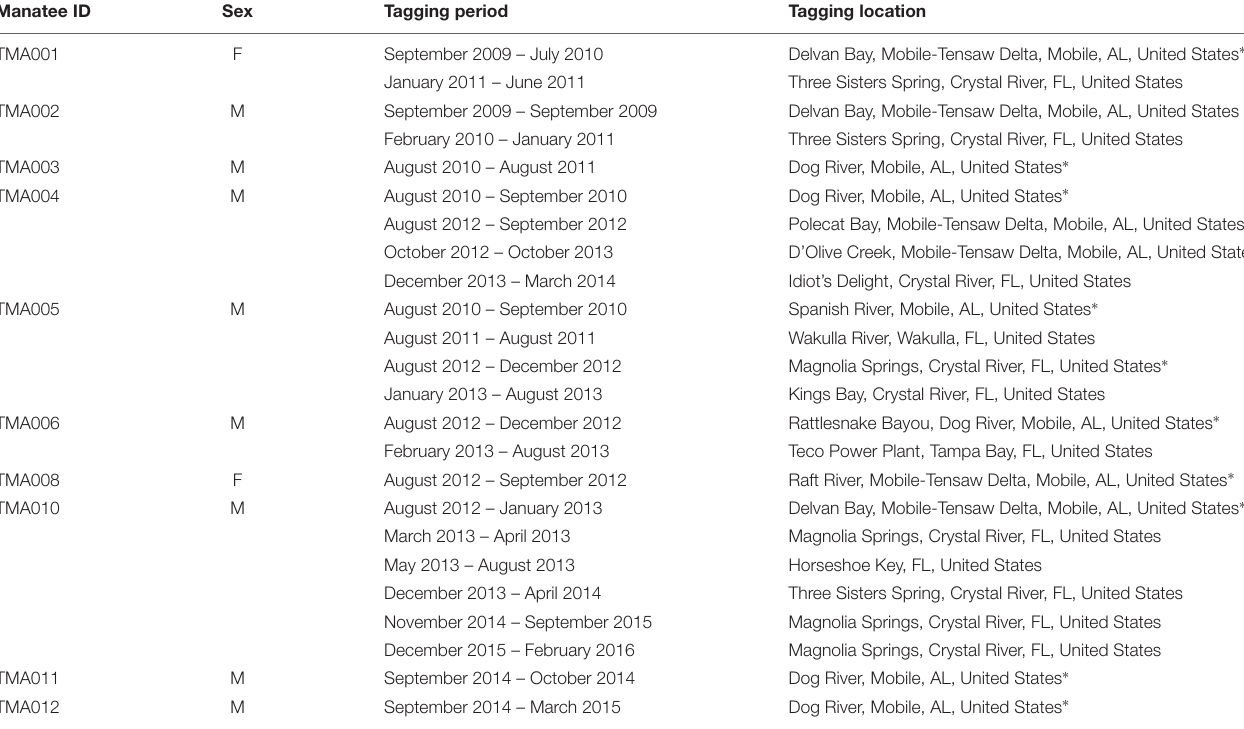
TABLE 1 | Manatee capture and retagging events. Manatee ID Tagging